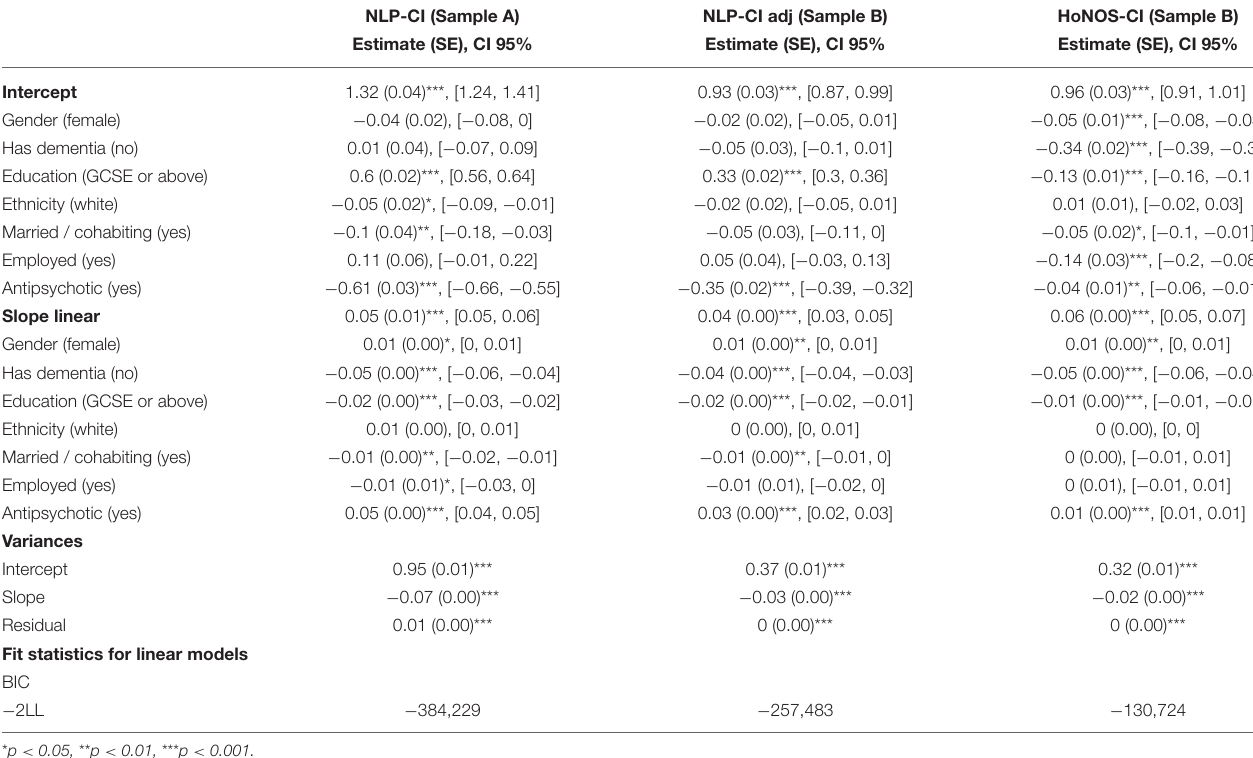
TABLE 6 | Estimates for the fully adjusted linear mixed model for HoNOS-CI and NLP-CI trajectories. NLP-CI (Sample A)